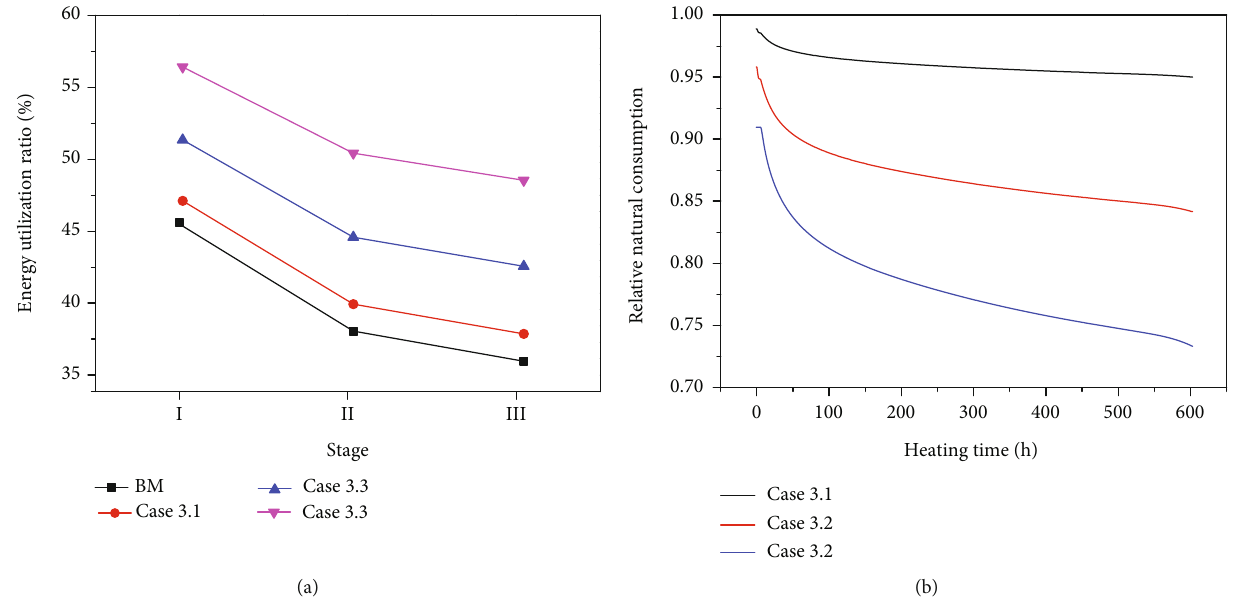
Figure 7: Energy utilization ratio (a) and relative natural gas consumption ( G